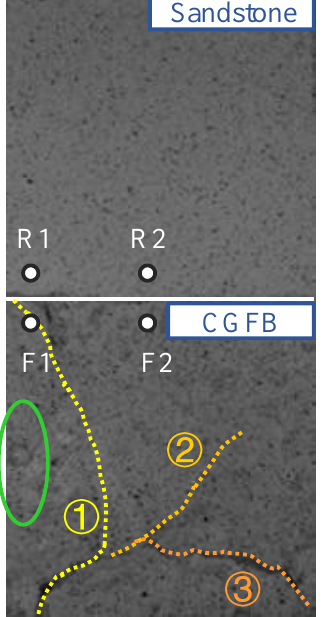
Figure 12. Displacement variation curve of the sandstone and the CGFB near the intersection.